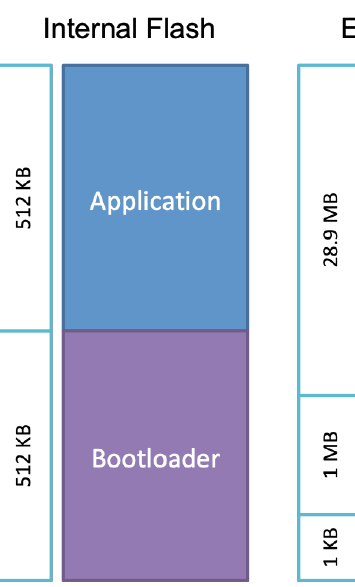
Figure 2. Internal and external flash memory